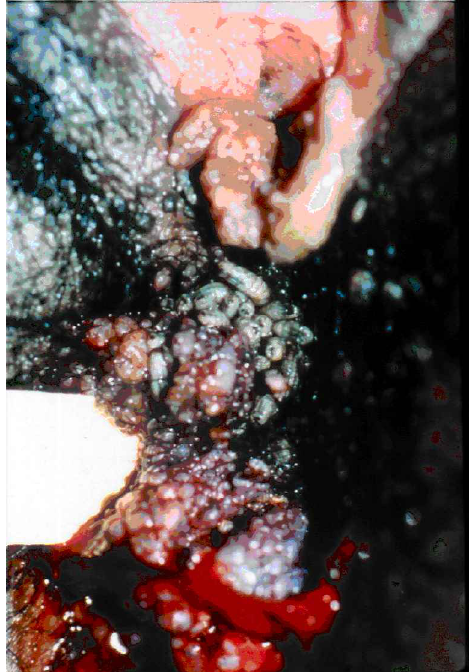
Figure 4 Case 2; extensive genital warts (human Papilloma virus lesions) and many larvae